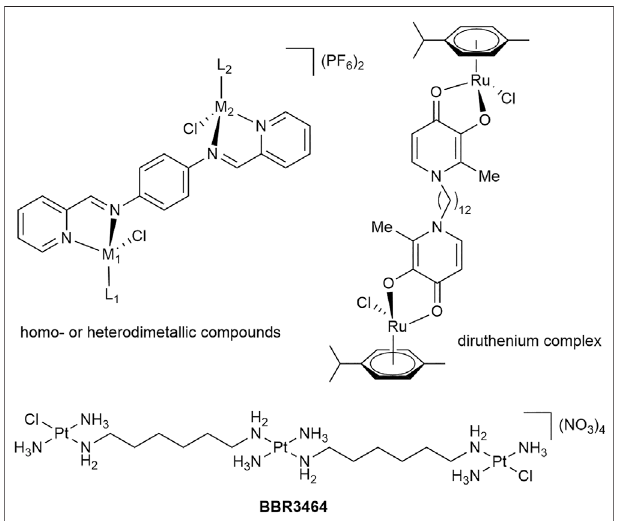
FIGURE 1 | Homo- and heterometallic complexes with anticancer activity.